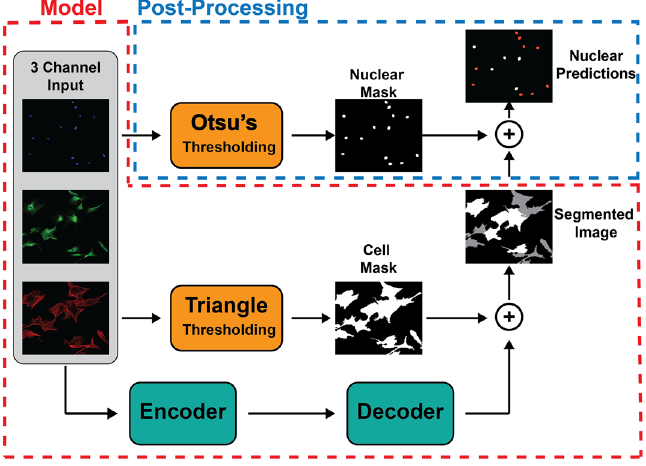
Figure 3. General workflow. The model supplements an encoder-decoder deep learning architecture with binary thresholding to generate a segmentation map. Post-processing then applies a nuclear segmentation map to predict individual cell